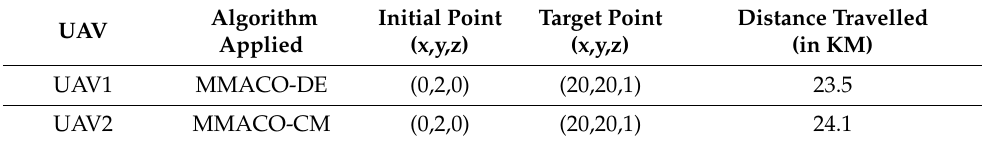
Table 3. Case 1 initial and target points.